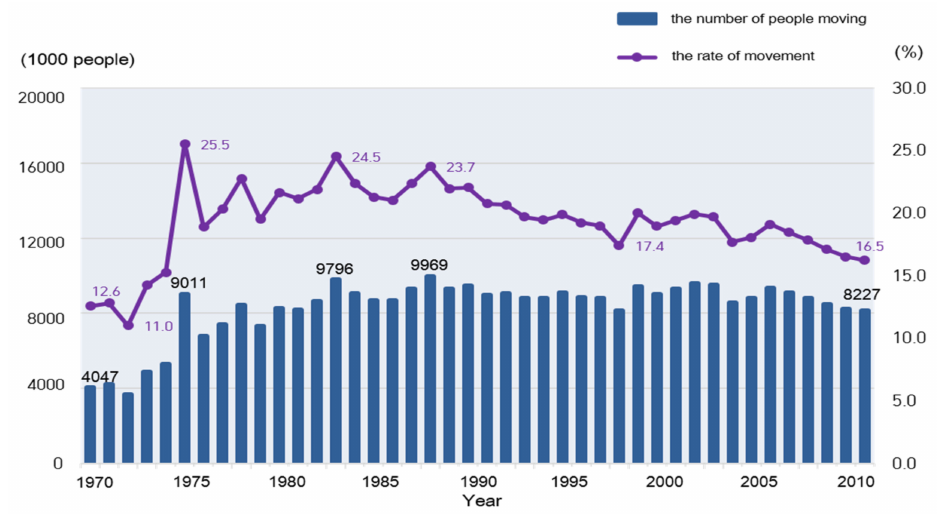
Figure 5. Trends in the number of people moving and the rate of movement (1970~2010) [10]. Second, in the 1980s, the growth of large cities led to urbanization. After the 1990s, the proportion of the population in the metropolitan area increased from 41.8 percent to 49.1 per- cent, but the proportion in special and metropolitan cities decreased from 49.3 percent